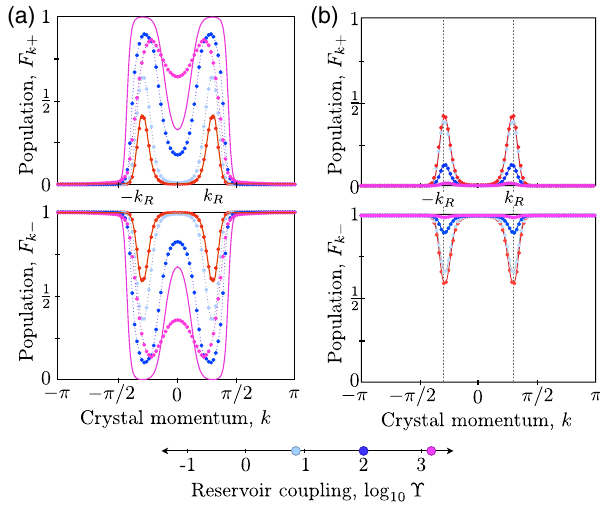
FIG. 4. Numerically obtained steady states of the system coupled to both bosonic and fermionic baths. The top and bottom panels show the distributions of electrons in the Floquet þ and − bands, respectively, for increasing strength of the coupling to the Fermi reservoir. We characterize the coupling strength by the ratio of tunneling and recombination rates ϒ ¼ 2 Γ 0 = W rec . [See Eqs. (8) and (10) for definitions of the k R ; þ rates.] Two types of Fermi reservoirs are studied. (a) Wide-band Fermi reservoir, whose Fermi level lies in the middle of the original band gap (the band gap of H 0 ). An increase in the coupling strength to such a reservoir leads to a substantial increase in the electron and hole densities n and n , due to e h photon-assisted tunneling. (b) Energy-filtered Fermi reservoir, whose Fermi level lies at the resonance energy E 0 in the original conduction band, i.e., in the middle of the Floquet gap of the driven system. The electron and hole densities n and n are e h suppressed via the coupling to the narrow-band Fermi reservoir. In all panels, the red data points are for a half filled system which is disconnected from the Fermi reservoir. The other colors correspond to the values of ϒ indicated at the bottom. The solid lines are fits to Floquet-Fermi-Dirac distributions, with separate chemical potentials for electrons and holes in the Floquet þ and − bands, respectively. The temperature taken for the fits is identical T ¼ 10 − 2 ℏ Ω . In these to the phonon and reservoir temperature k B simulations, the parameters for the photon (recombination) and phonon baths are kept fixed at the values yielding the green curve in Fig. 3, while we vary the overall scale of the coupling strength to a homogeneously coupled fermionic